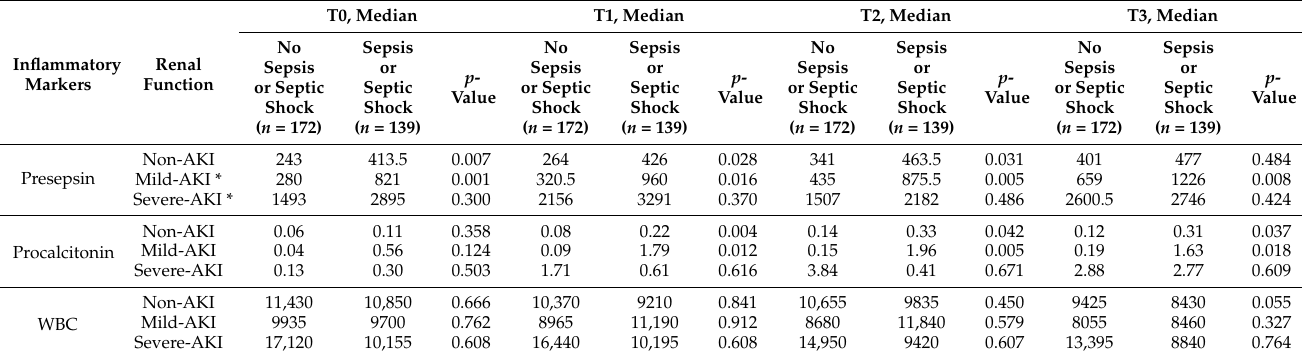
Table 6. Median values of inflammatory markers in patients with and without postoperative sepsis, according to AKI severity (non-AKI, n = 210; mild-AKI, n = 88; severe-AKI, n = 13).